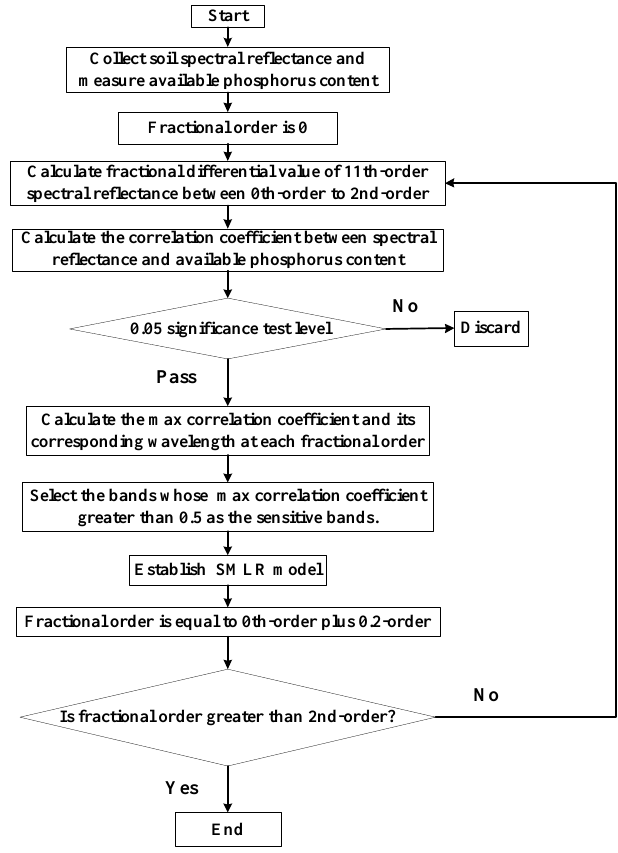
Figure 3. Flow chart of the quantitative analysis model.